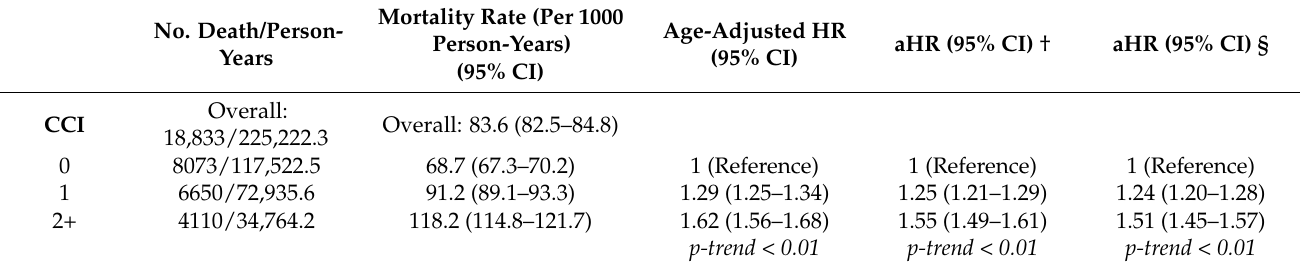
Table 2. Association of all-cause mortality with CCI in stage I-II NSCLC patients undergoing thoracoscopic resection (N = 61,760).